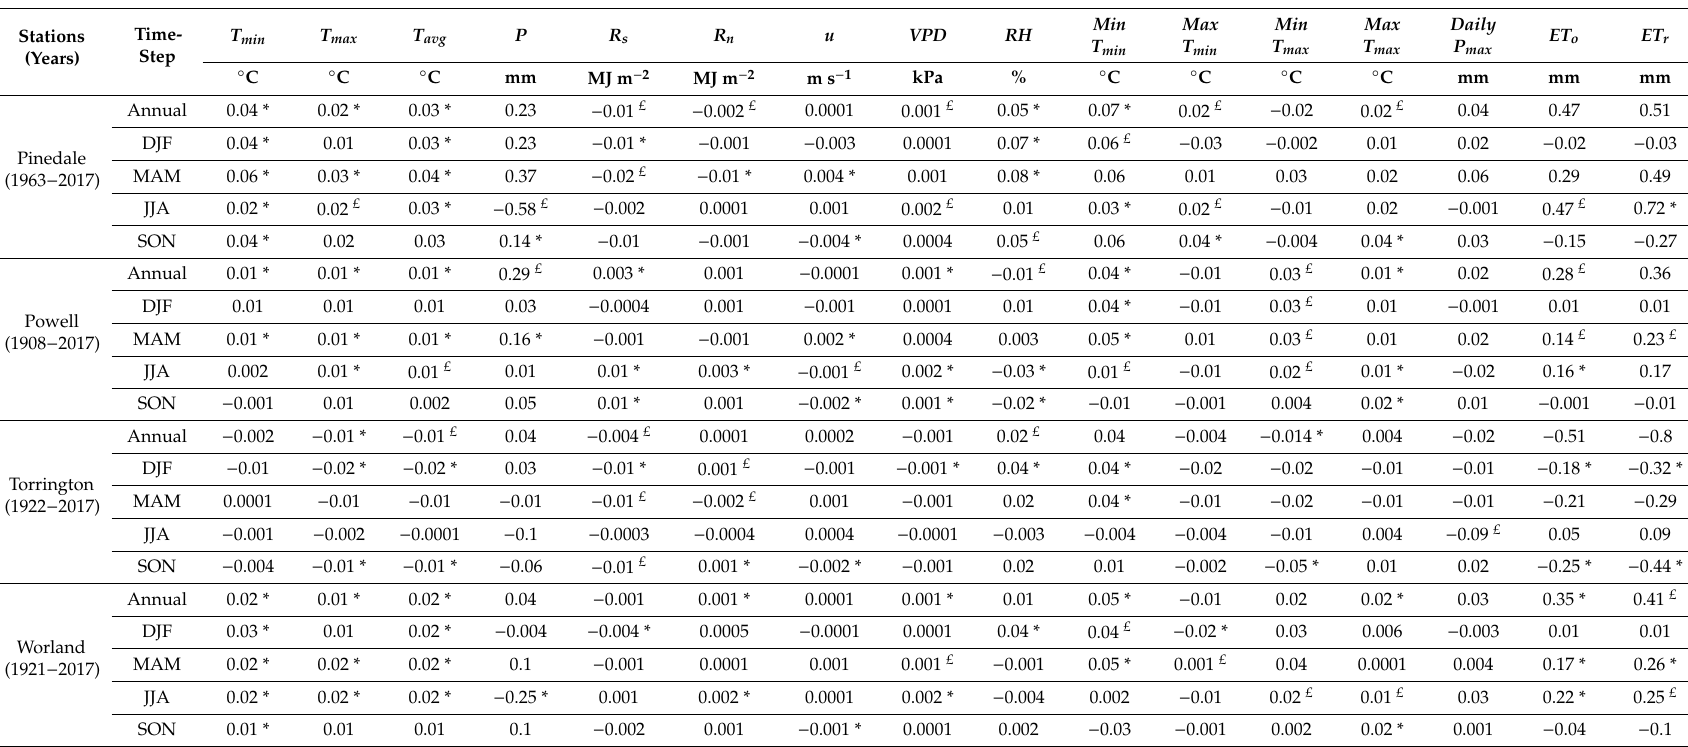
Table 3. Theil-Sen’s slope (Qi) of the meteorological variables and grass and alfalfa reference evapotranspiration at annual and seasonal time-step for four weather stations in the state of